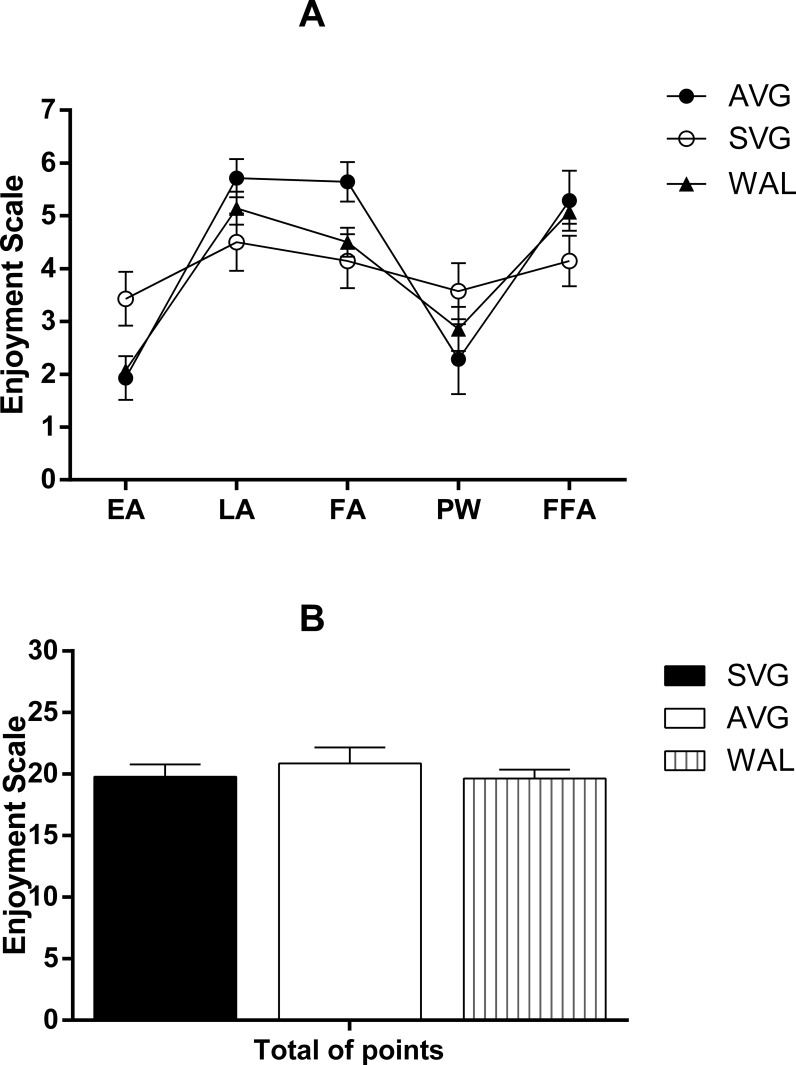
Values that describe the Enjoyment Scale (A) values obtained in each of the points raised in the scale and (B) the sum of these points for each study session. EA–enjoy the activity; LA–like the activity; FA–had fun with the activity; PW–physically well to perform the activity; FFA–feel frustrated when performing the activity; Data are mean and standard error of the mean. (N = 14). One-way Anova. No significant differences were found (p> 0.05). Source: Silva, 2015.